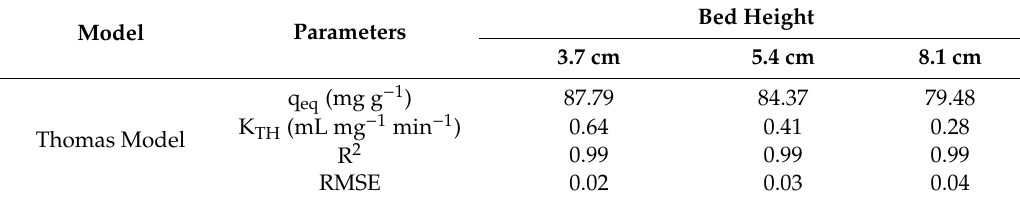
Table 6. Estimated operational variables extracted by the Thomas model for CV adsorption